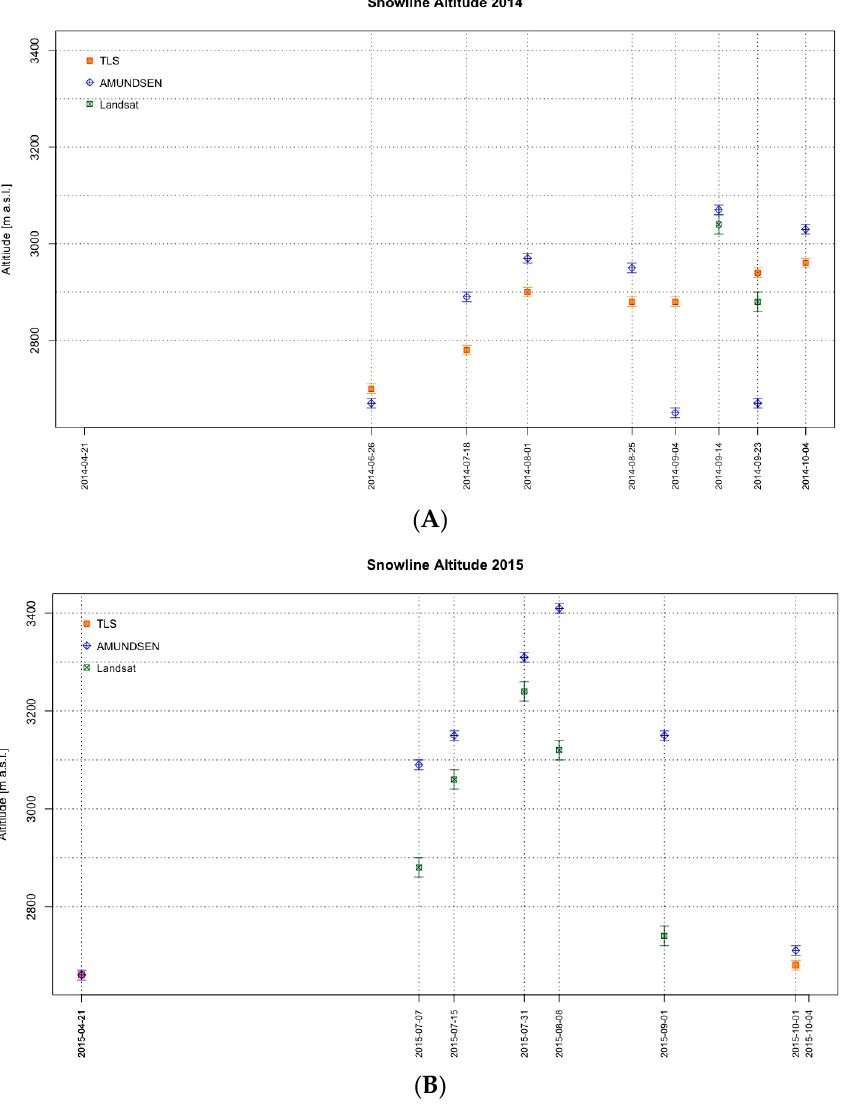
Figure 4. TLS, AMUNDSEN and Landsat determined snow line altitudes in the years ( A ) 2014 and ( B ) 2015. The uncertainties of the SLA are determined with the range of the elevation bins: ±20 m for the Landsat data and ±10 m for TLS and AMUNDSEN.